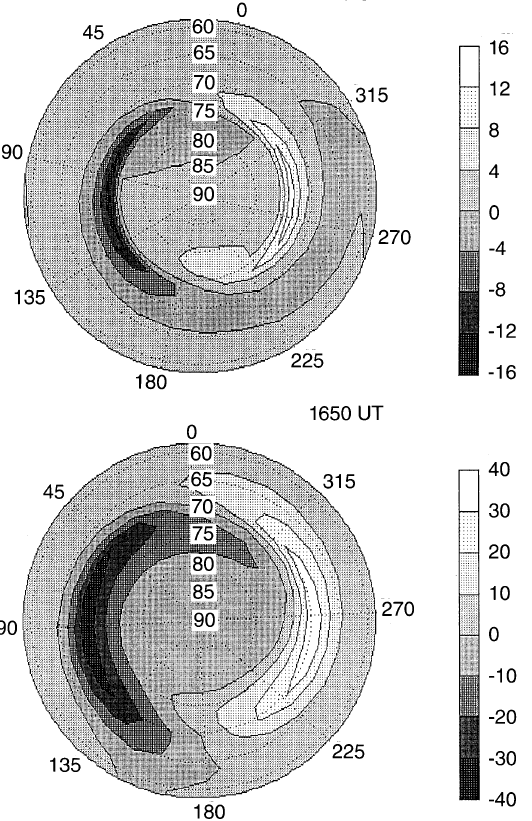
Fig. 1. The north geomagnetic ( (cid:85) , (cid:75) ) polar plots of the integrated magnetospheric conductivity (Sm) at the growth phase ( top ) and at the expansion phase ( bottom ) of the substorm; the Sun position is at the top of the figure